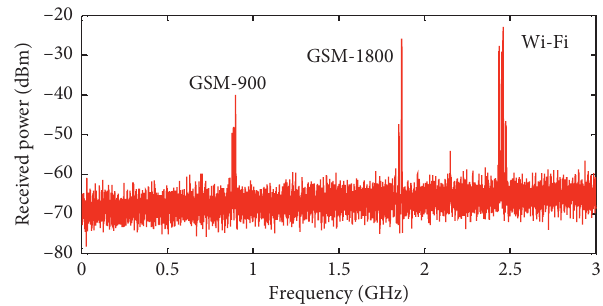
Figure 15: Measured power spectrum by the proposed antenna array inside the